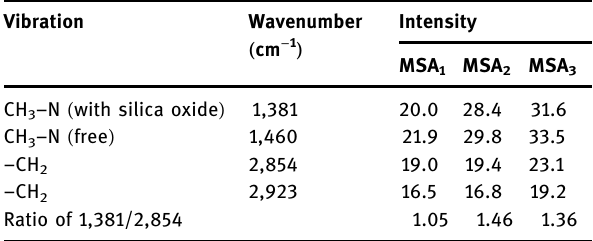
Table 1: Vibrational intensity of the functional groups in CTAB Vibration